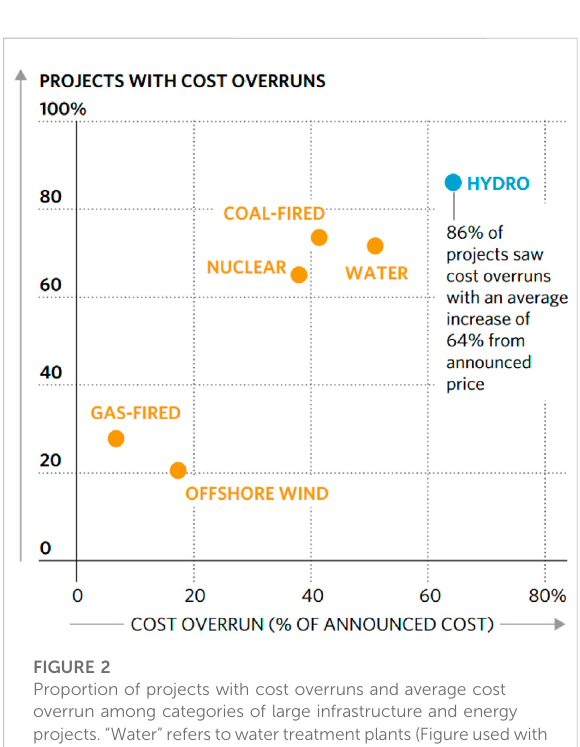
FIGURE 2 Proportion of projects with cost overruns and average cost overrun among categories of large infrastructure and energy projects. “ Water ” referstowater treatment plants (Figureused with permission from Opperman et al. (2017), adapted from EY